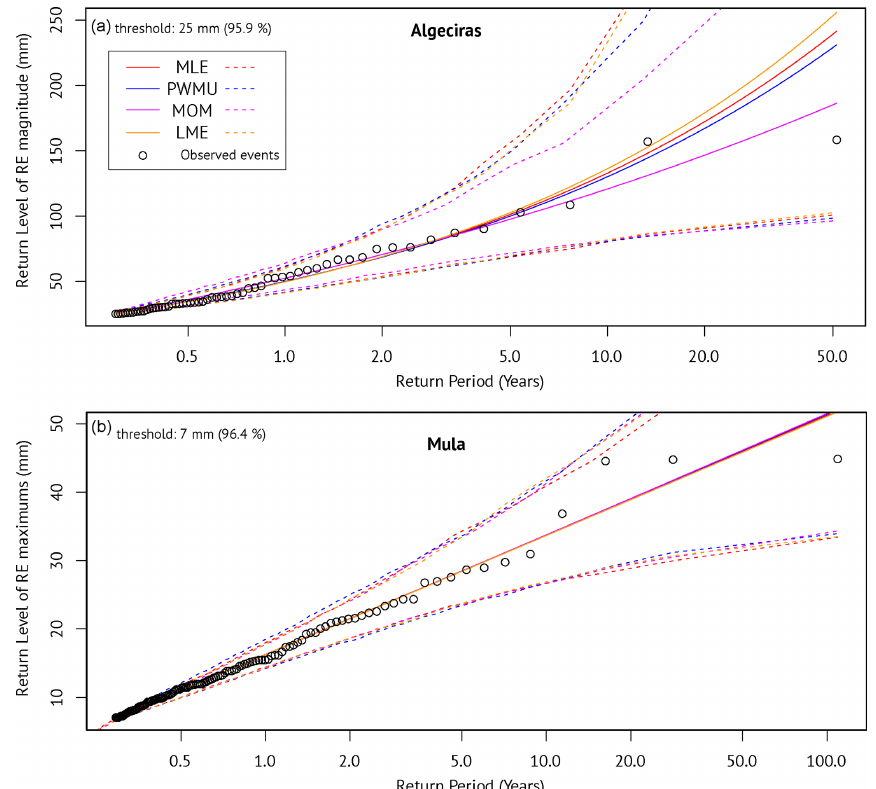
Figure 8. Return levels (RLs) of magnitude of the events in Algeciras (a) and cumulated hourly maximums in Mula (b) . Solid lines show the RL estimated for different return periods with four different methods: maximum likelihood estimation (MLE), unbiased probability weighted moments (PWMU), moments (MOM), and likelihood moment (LME). Dashed lines show the confidence intervals. Dots are the observed magnitude and maximums of Algeciras and Mula, respectively. RLs of 98% and maximum probabilities of flow generation are